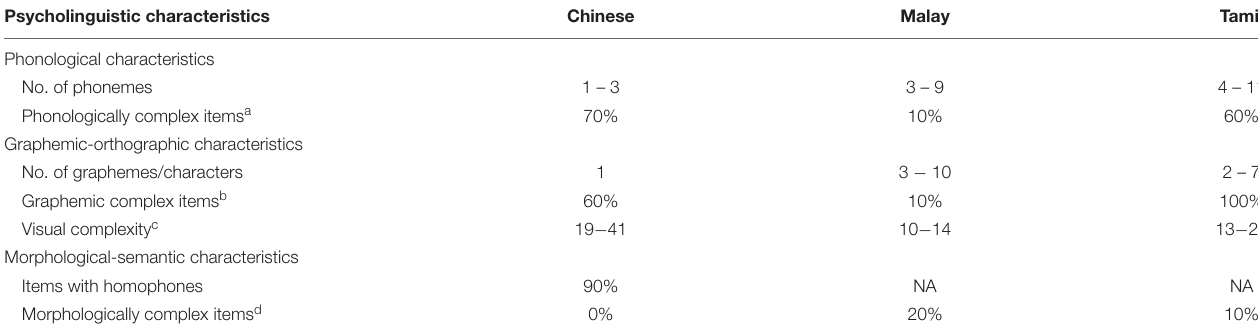
TABLE 3 | Psycholinguistic characteristics of the three Asian language versions of the spelling